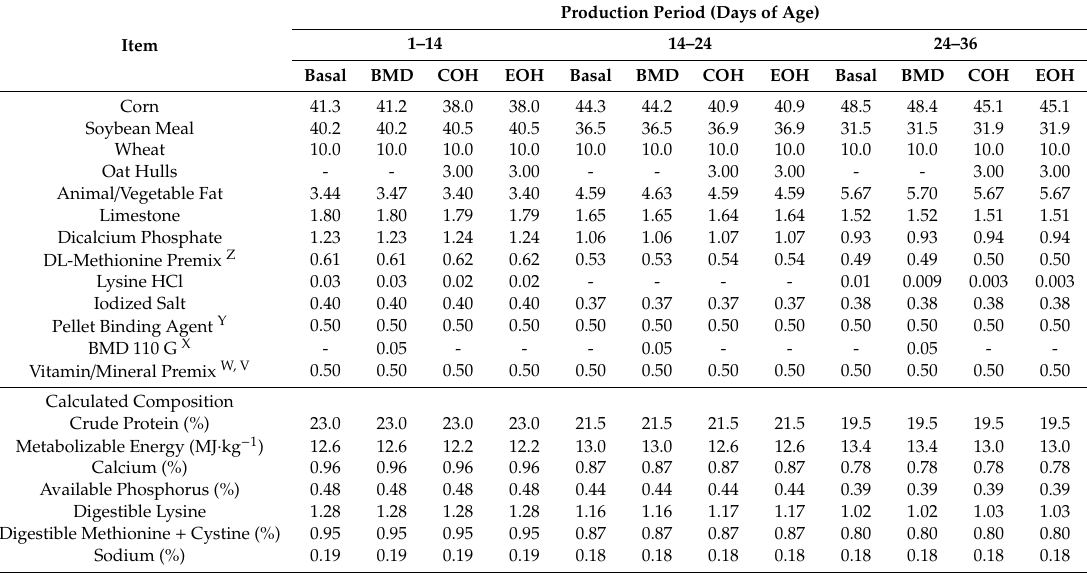
Table 2. Ingredient and nutrient compositions of diets in the experiment